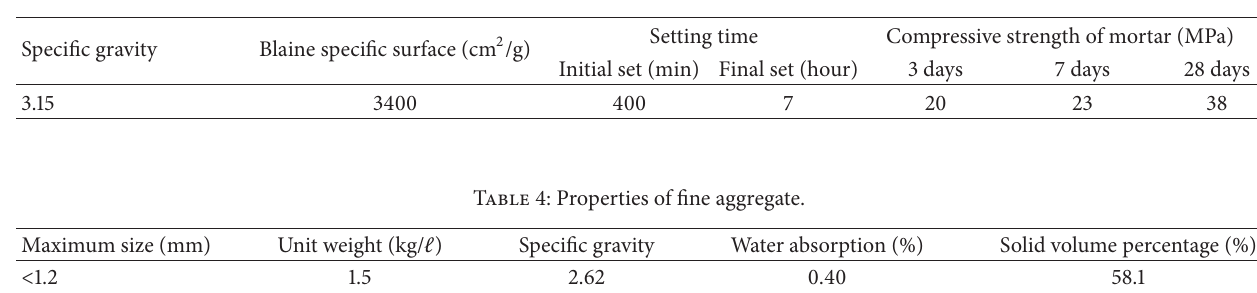
Table 3: Physical properties of ordinary Portland cement (OPC).